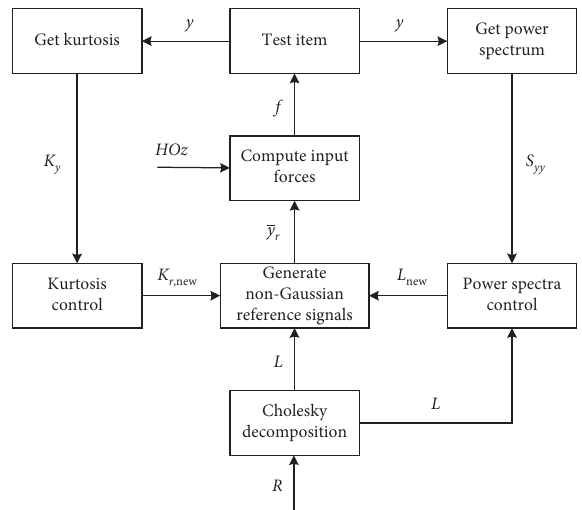
Figure 3: Flow chart of a super-Gaussian test